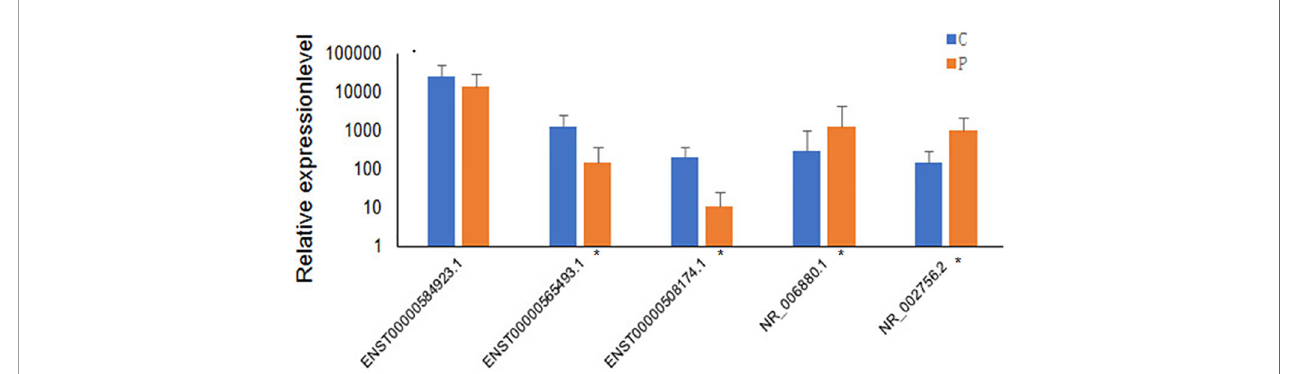
FIGURE 4 | Validation of high-throughput sequencing results using qRT-PCR analysis of 5 randomly selected lncRNAs. The blue columns refer to the control group (n=60), and orange refers to PCOS group (n=56). Groups with signi fi cant differences are marked with *P